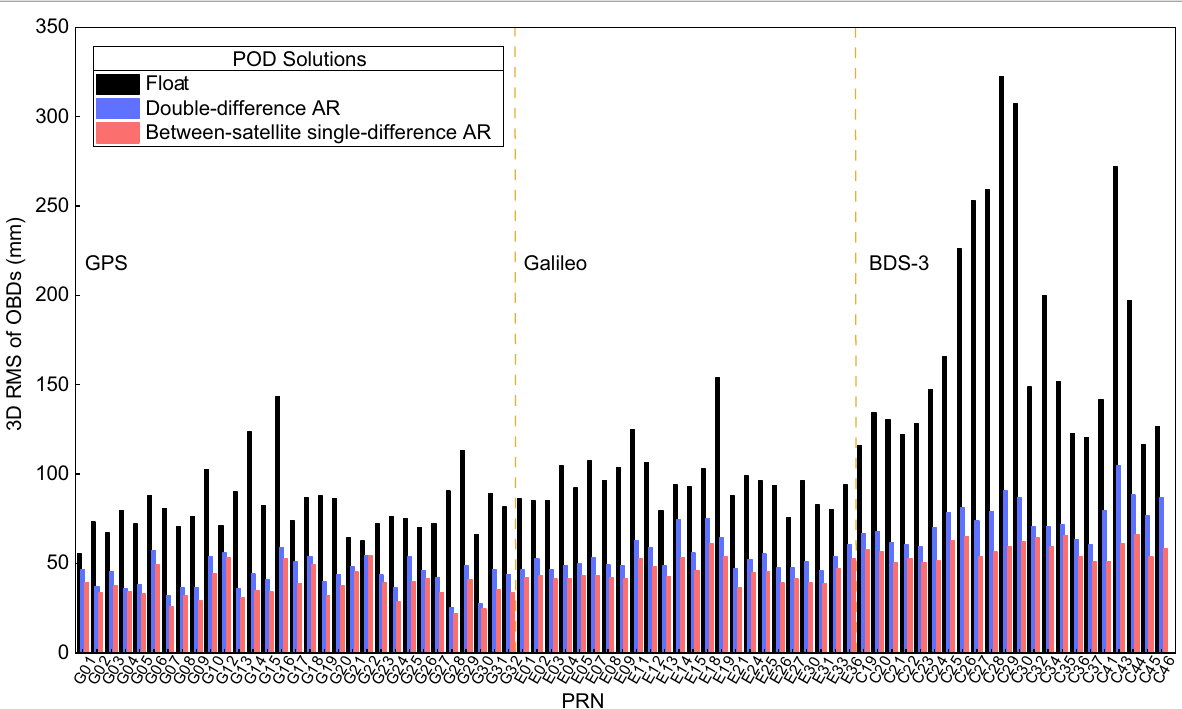
Fig. 6 3D RMS of OBDs. The black, blue, and red bars represent RMS with ambiguity-float, double-difference AR, and between-satellite single-difference AR